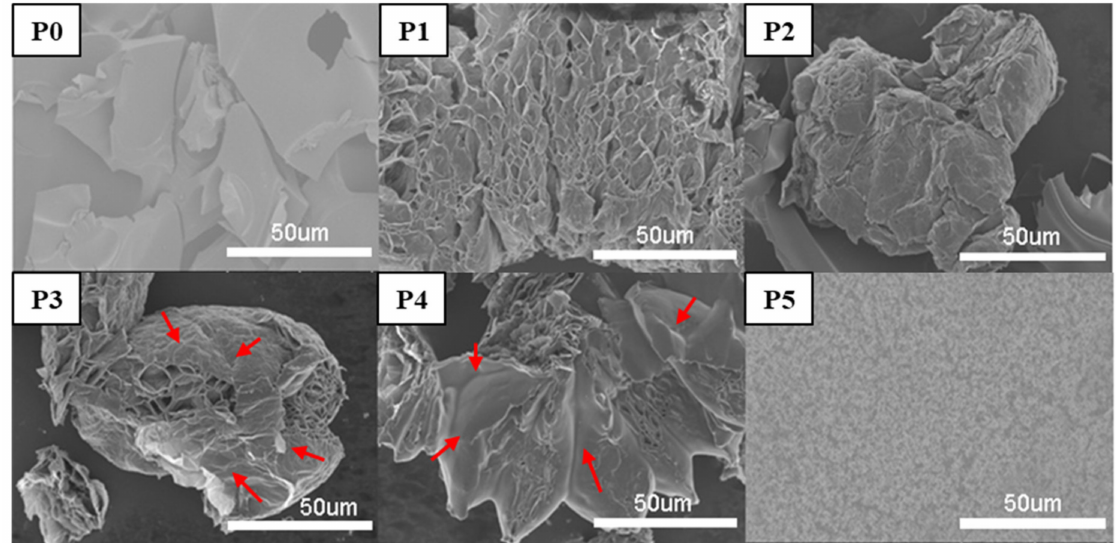
Figure 10. SEM photos of the residue char after the cone calorimeter test.